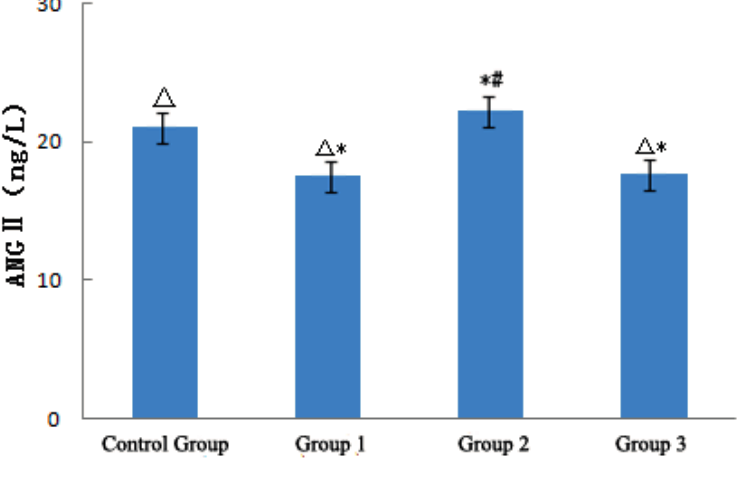
Figure 5. Analysis of ANG II in ApoE − / −